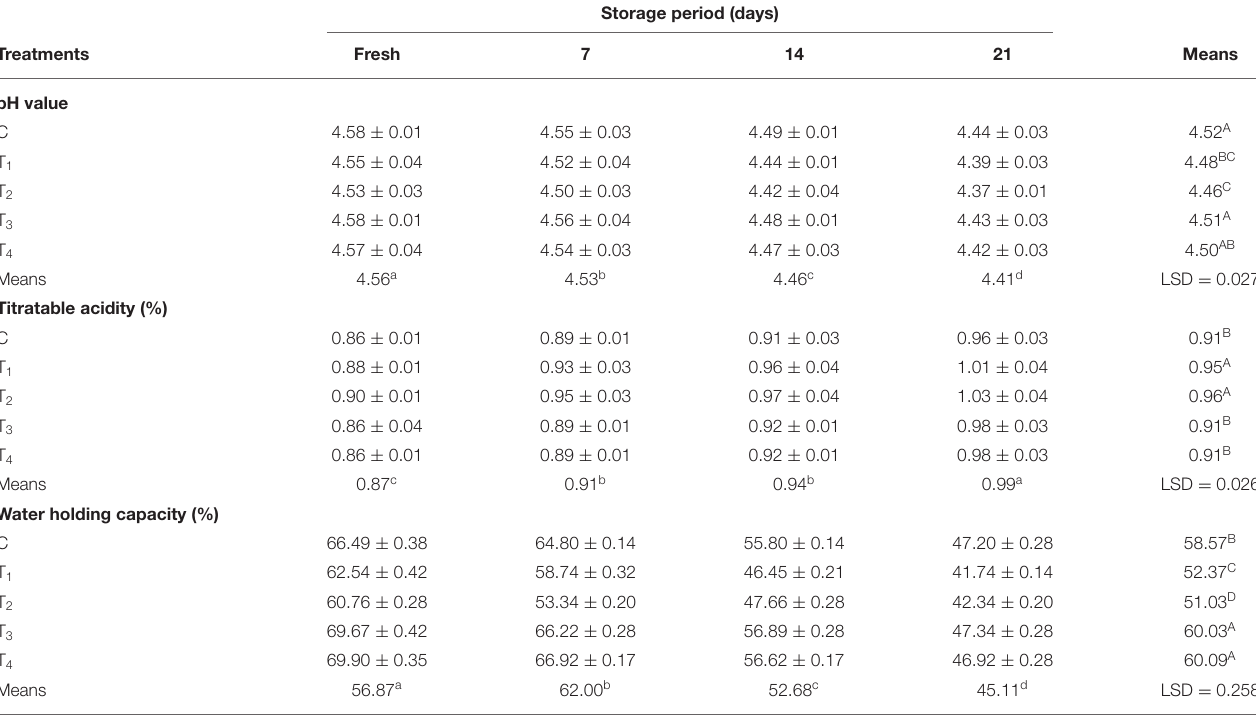
Storage period (days)